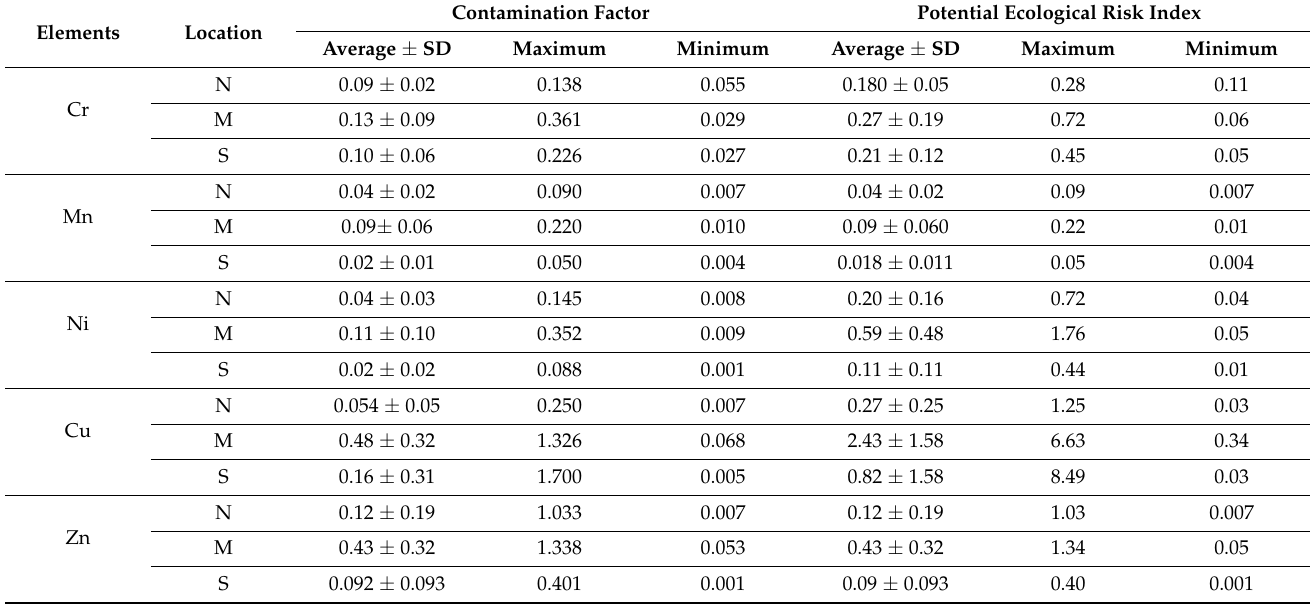
Table 4. Contamination Factor and Potential Ecological Risk Index for metals of interest from different locations in the Jeddah